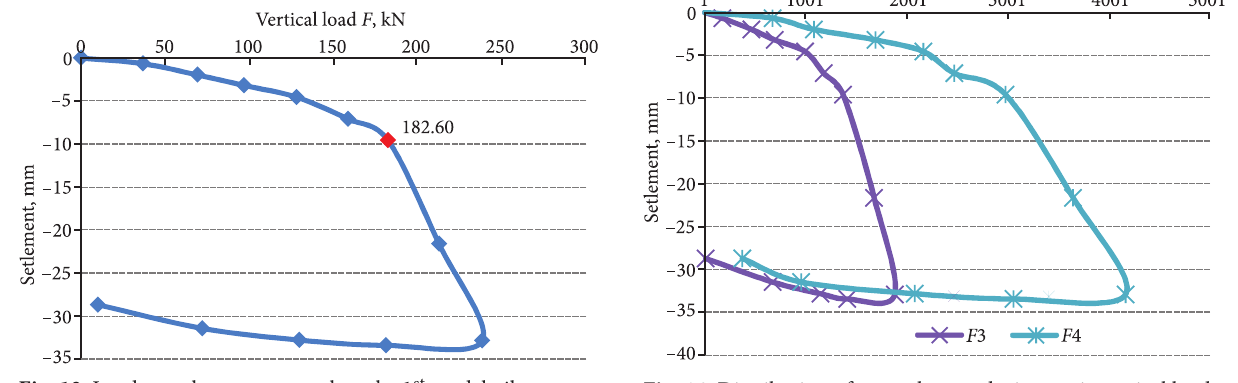
fig. 14. Distribution of normal stress during static vertical load test when the 1 st model pile was at a depth of 1.4